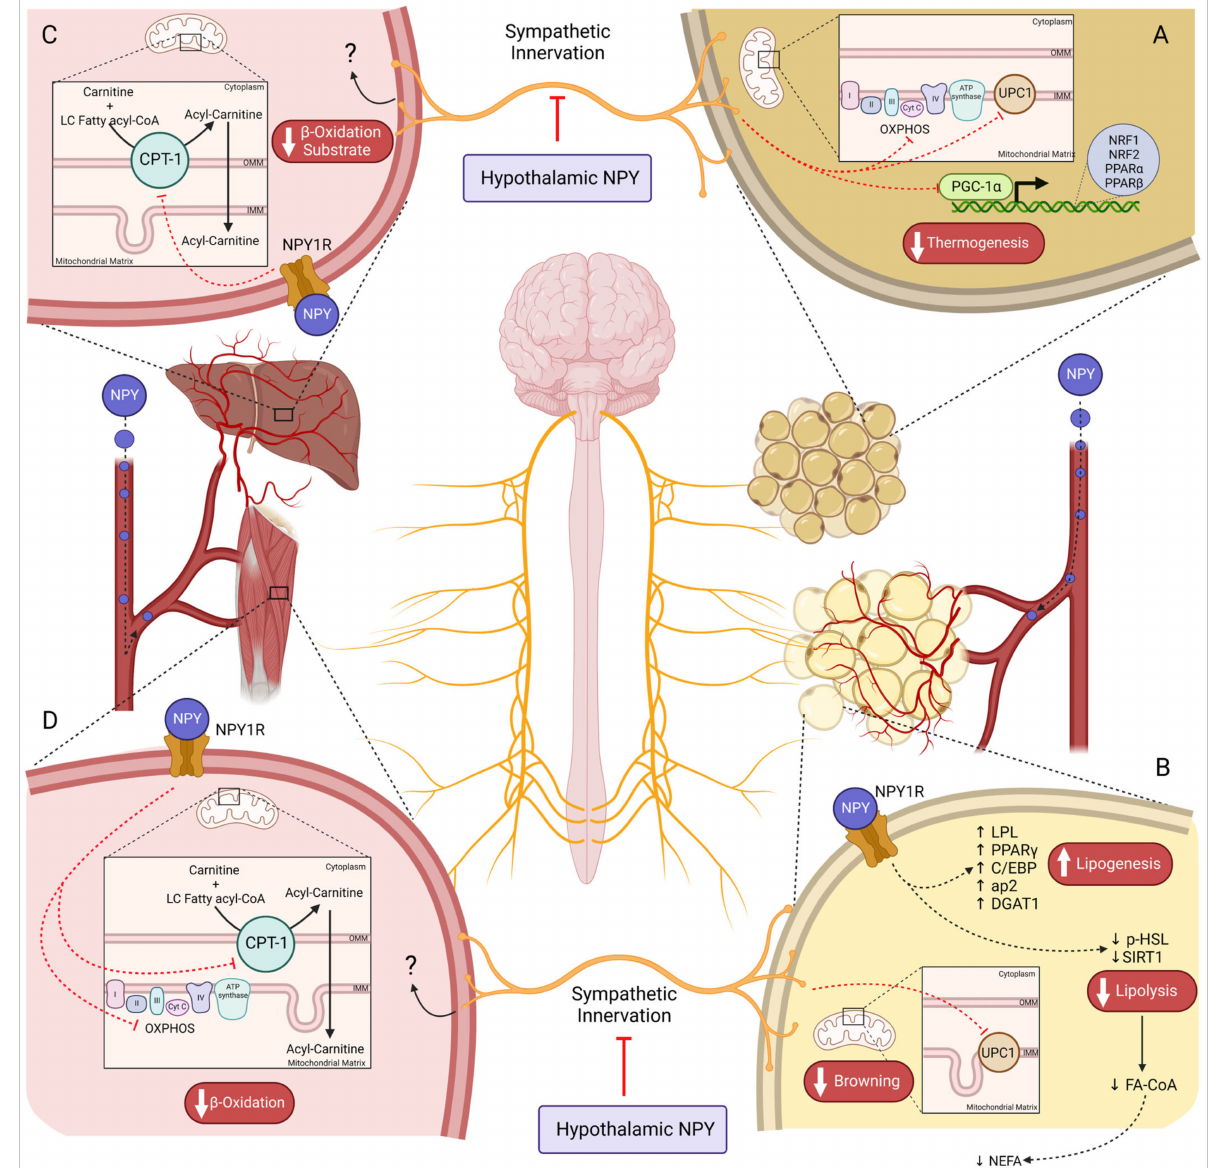
Figure 2. NPY controls energy expenditure by regulating cell metabolism on several